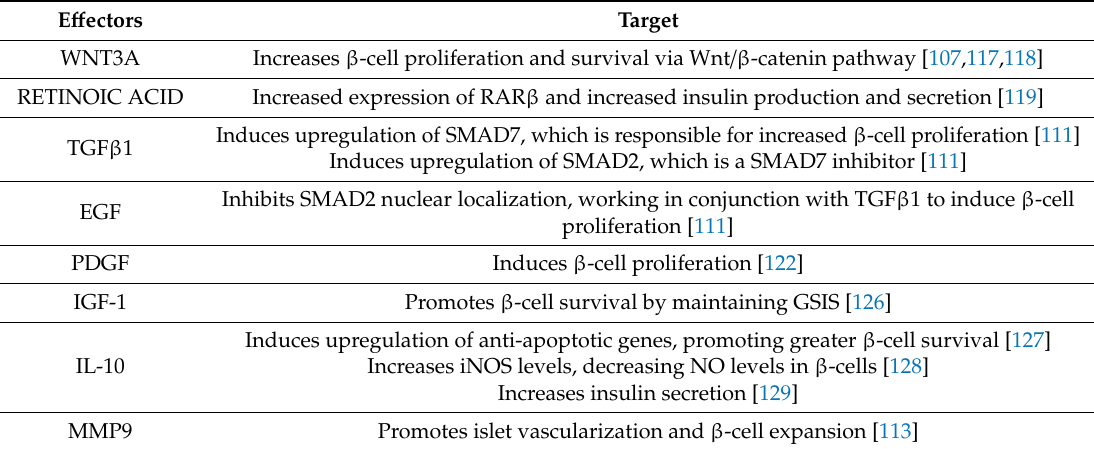
Table 2. Macrophages secreted factors that have a positive e ff ect on functional β -cell